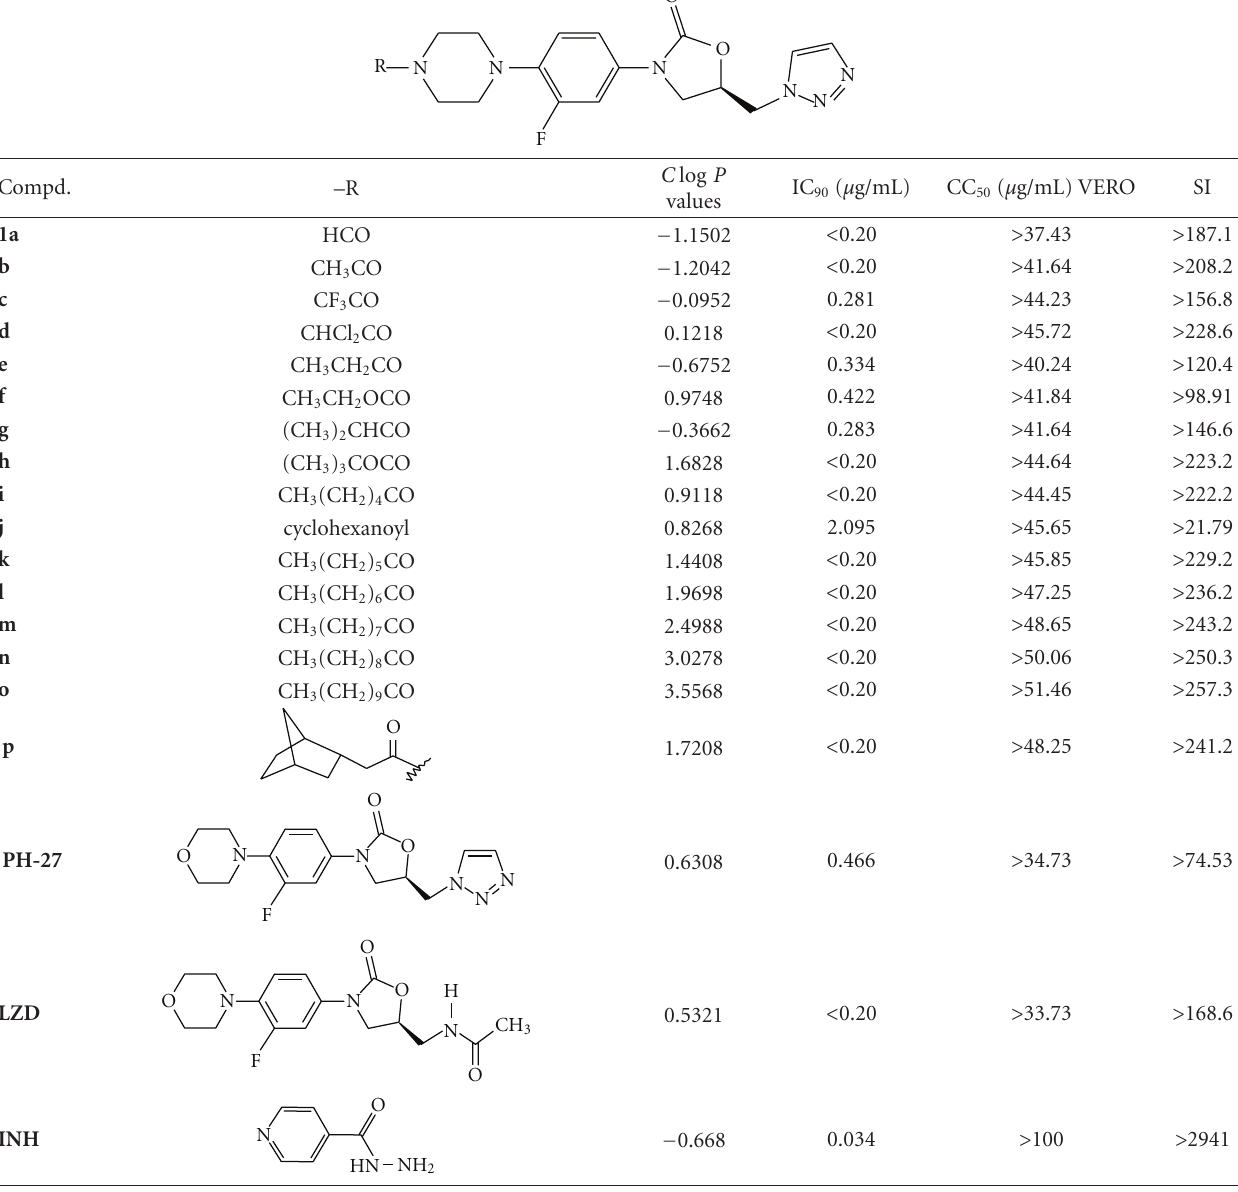
Table 1: In vitro antimycobacterium activity of 4N-acylpiperazinyl oxazolidinones against M. tuberculosis H37Rv.